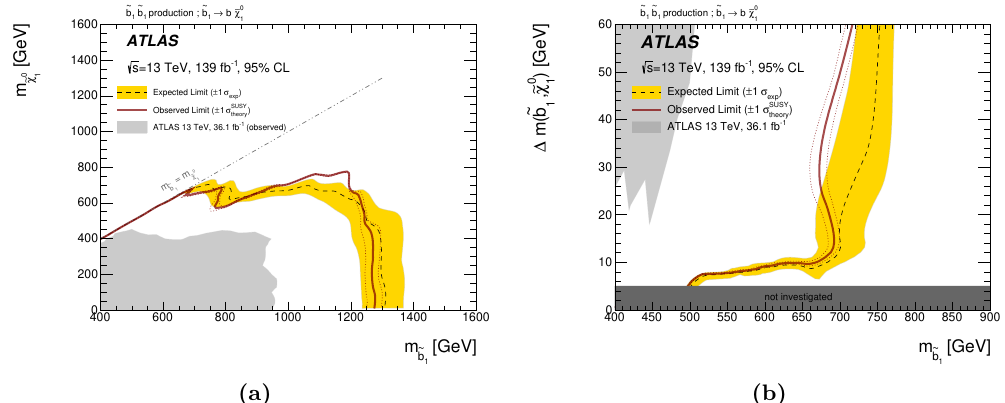
Table 7 . Left to right: SM expectation from background-only fit for the model-independent regions, 95% CL upper limits on the visible cross-section ( h (cid:15)σ i 95 expected ( S 95 ) number of signal events. The last two columns indicate the CL exp confidence level observed for the background-only hypothesis, and the discovery p -value ( p ( s = 0) ) capped at a value of 0.5.